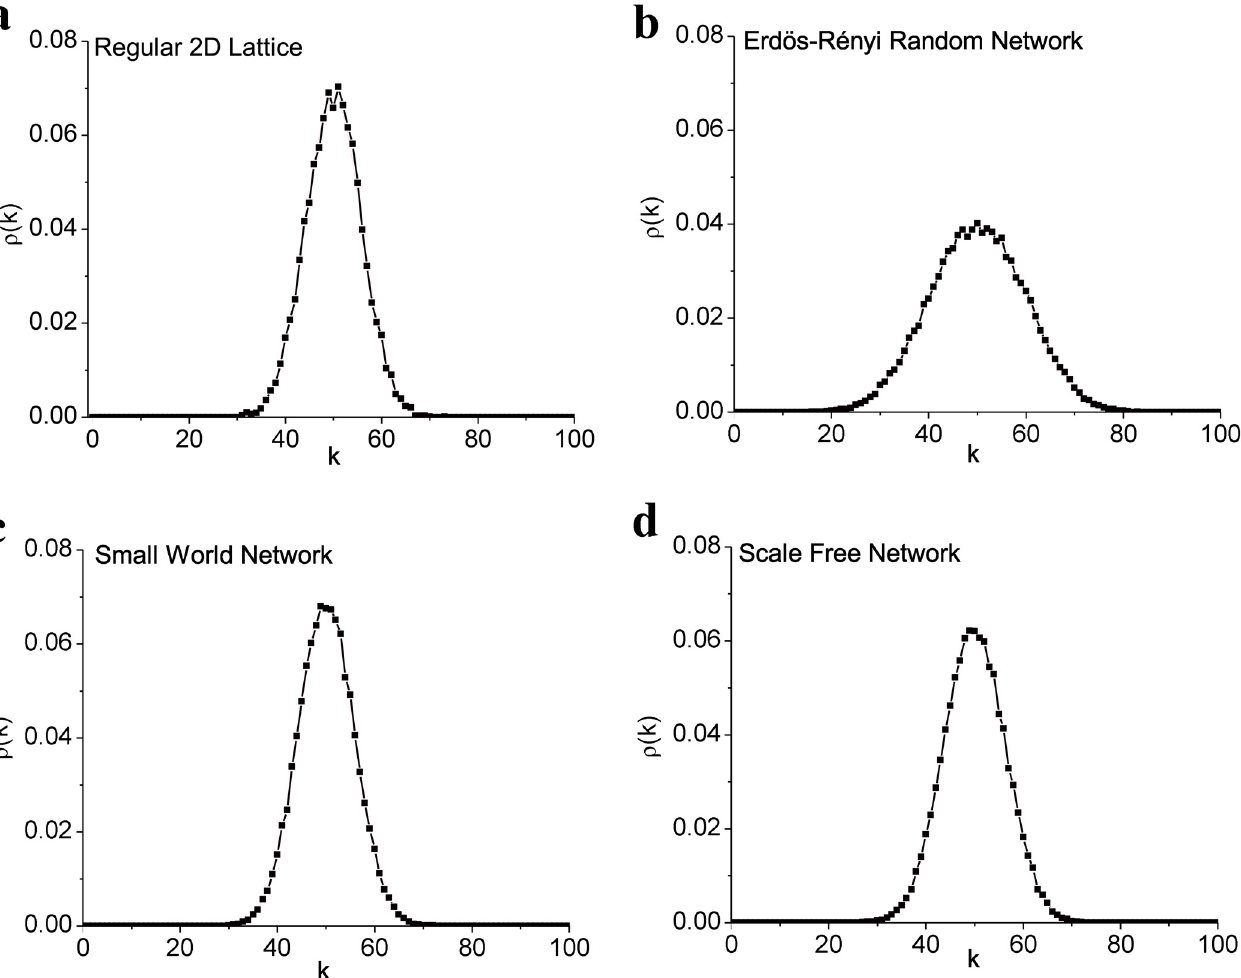
Fig 10. Asymptotic probability distribution for networks with different topologies. In all cases N = 100, D = U = 5, t = 10,000, and the number of realizations is 50,000. The theoretical curve is drawn with effective numbers of frozen nodes D ef and U ef : (a) regular 2-D lattice D ef = U ef = 150; (b) Erdös- Rényi random network D ef = U ef = 17; (c) small world network D ef = U ef = 143; (d) scale-free D ef = U ef =